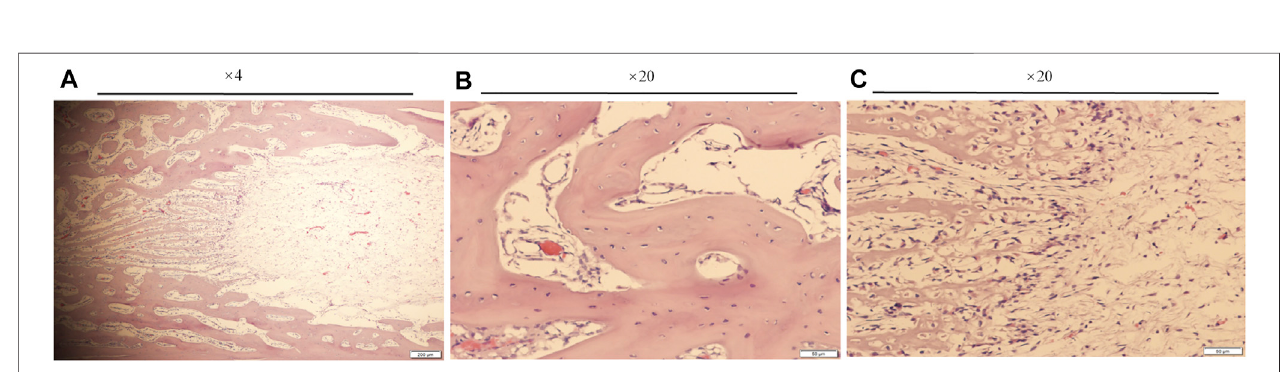
FIGURE 9 | The paraf fi n sections and HE staining of the bone sample 21 days after the external cap implant grafted, observed using a Histological microscope (magni fi cation ×4, ×20). These images from (A – C) were different areas of a sample from the distal to the proximal, at different magni fi cations gradually.